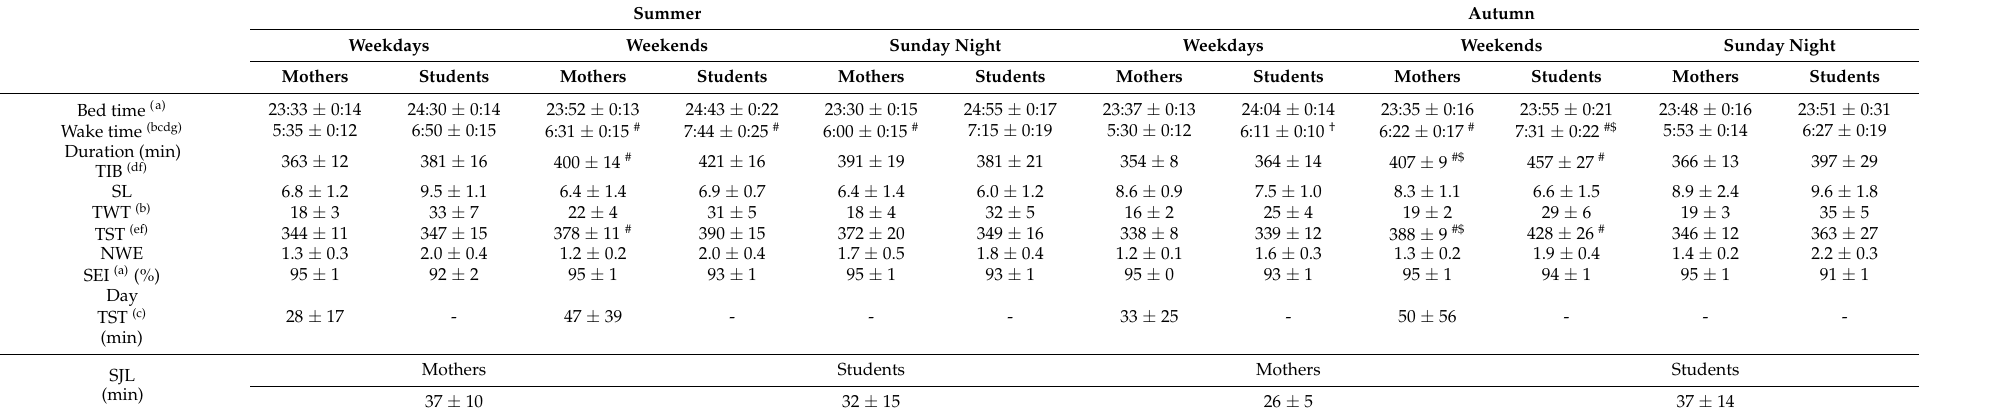
Table 1. The results of actigraphic measurements. Summer Autumn